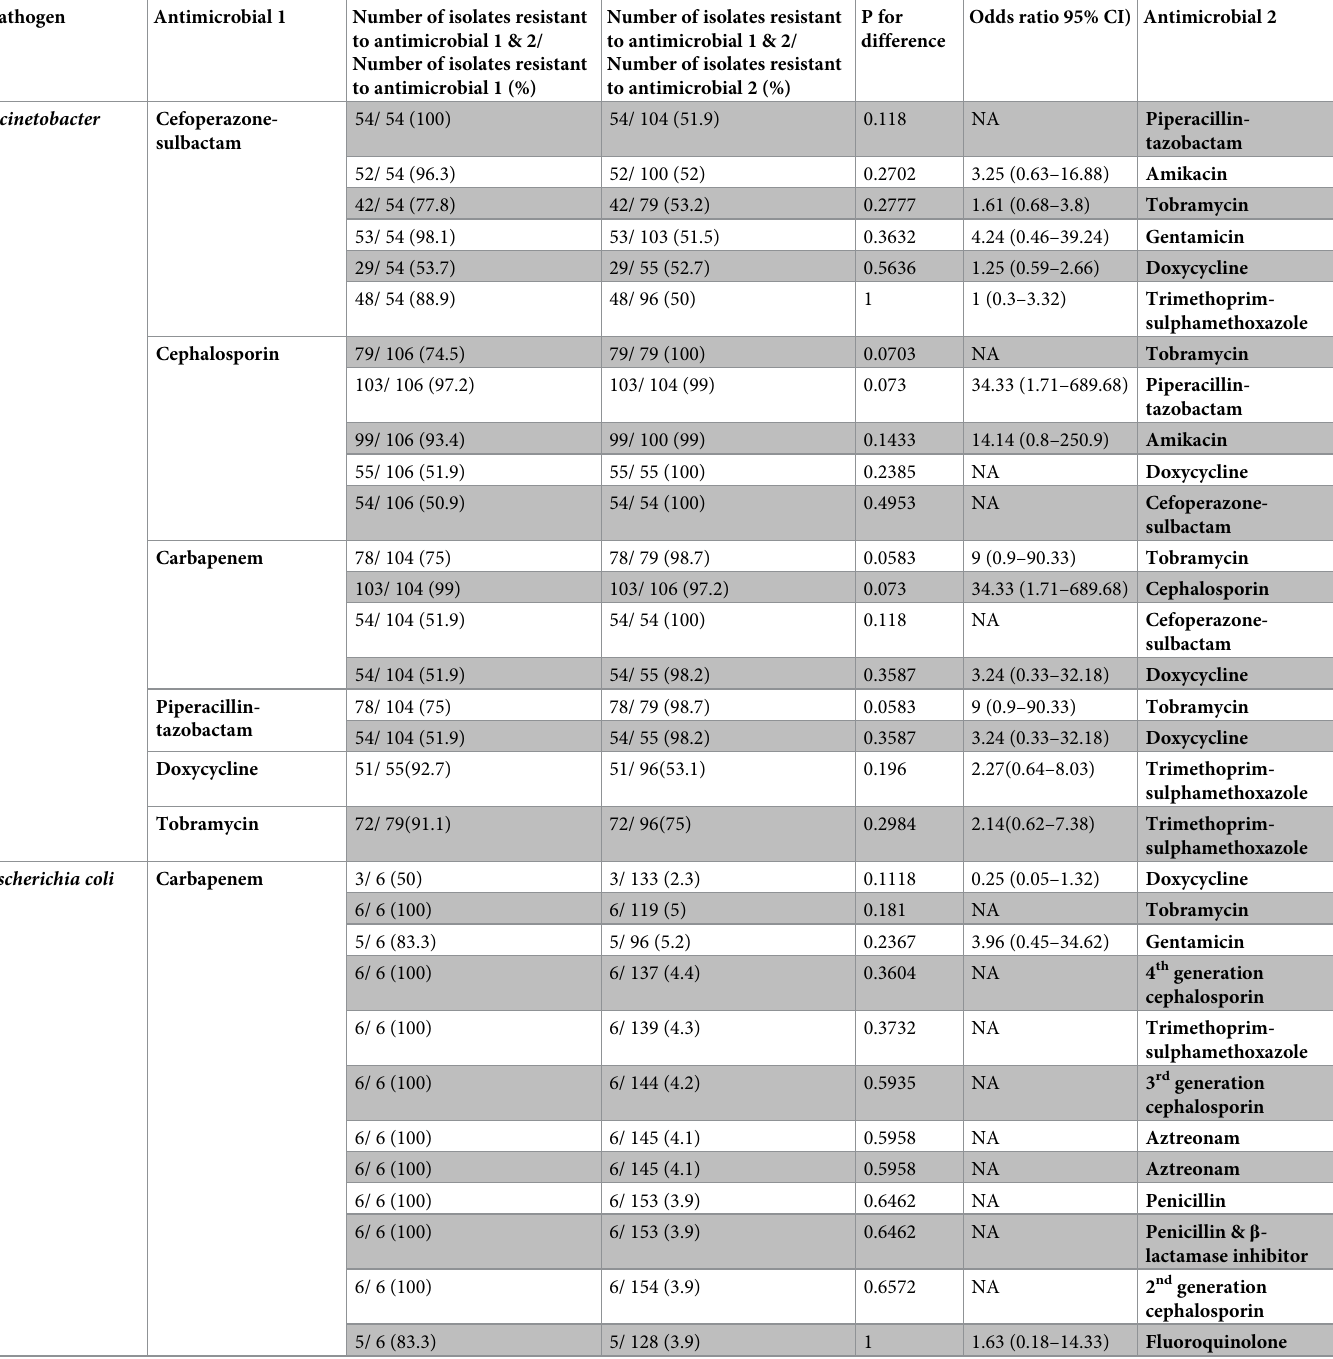
Table 7. Selected co-resistance trends in pathogens isolated from blood and cerebrospinal fluid (CSF) cultures in Pakistan (2011–2015).